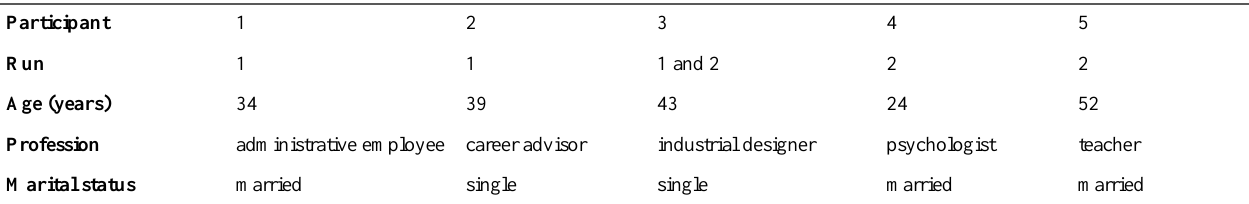
Table 1. Characteristics of participants in the pilot